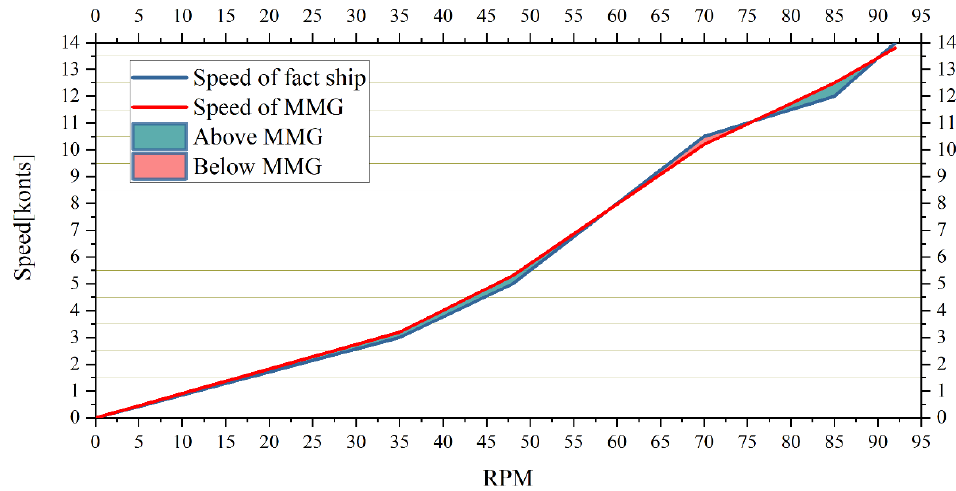
Figure 10. Difference between real ship and simulation ship.